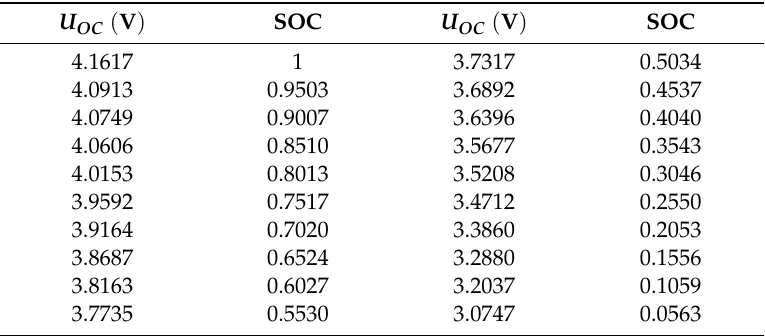
Table 2. U oc and SOC corresponding relationship value.